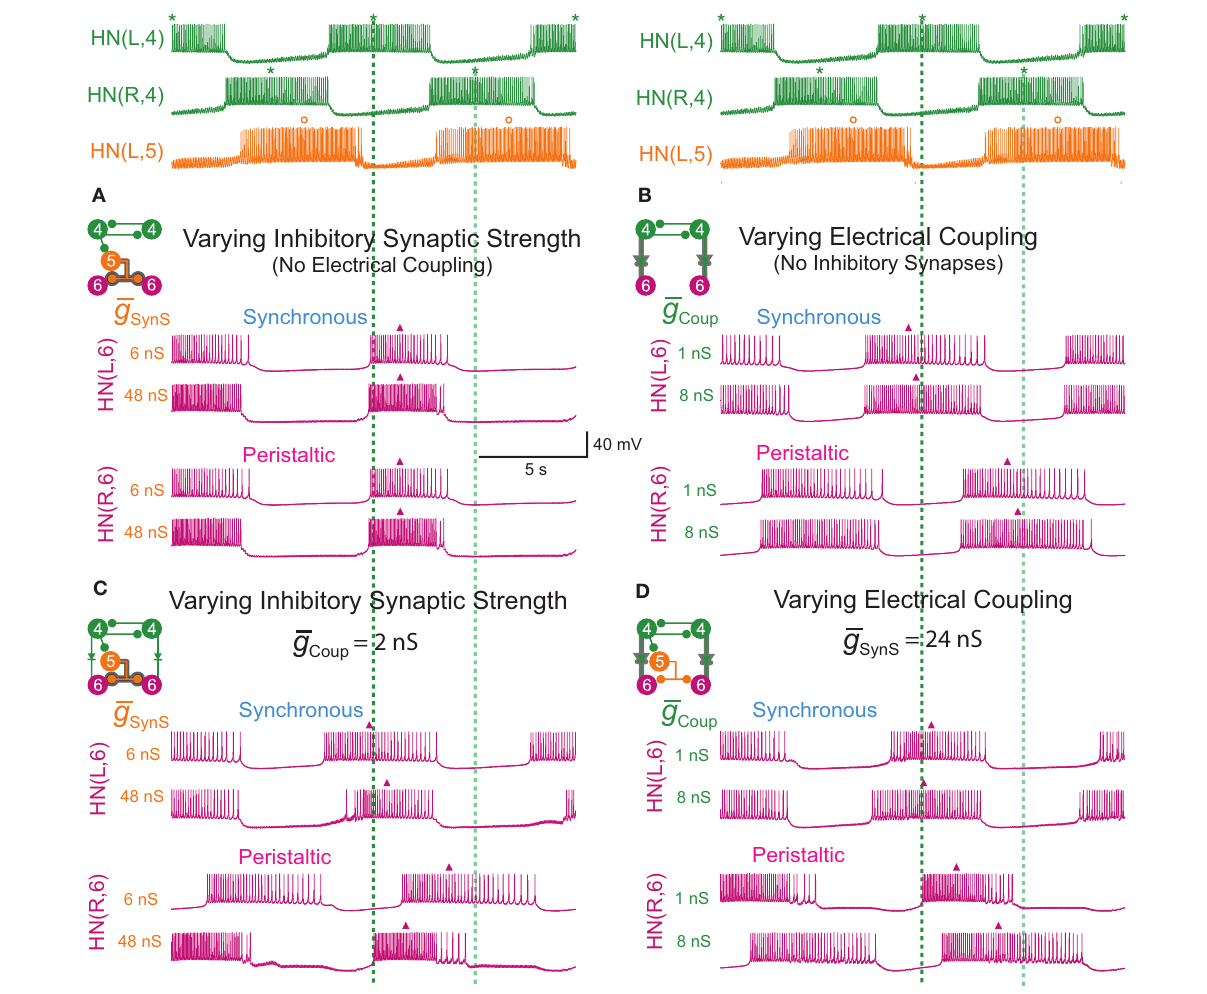
Figure 2 | inhibitory synaptic input ( g SynS ) and electrical coupling and ( g Coup ) acting together can alter the phasing of the middle premotor interneurons. The CPG was simulated as described in Section “Materials and Methods” (left synchronous/right peristaltic) for parameter variations, but only activity of the HN(4) (front premotor), the active HN(5) switch interneurons, and the HN(6) (middle premotor) interneurons are illustrated. The phasing of the HN(4) and HN(5) interneurons is invariant across the variation of g SynS and g Coup so they are illustrated only once at the top above each corresponding column of lettered panels (A–D) . Vertical dashed lines (dark green HN(4) peristaltic, transparent green HN(4) synchronous) are dropped from the HN(4) interneurons to illustrate the phase differences between front and rear premotor interneurons. The insets indicate which inputs onto middle premotor interneurons were present and